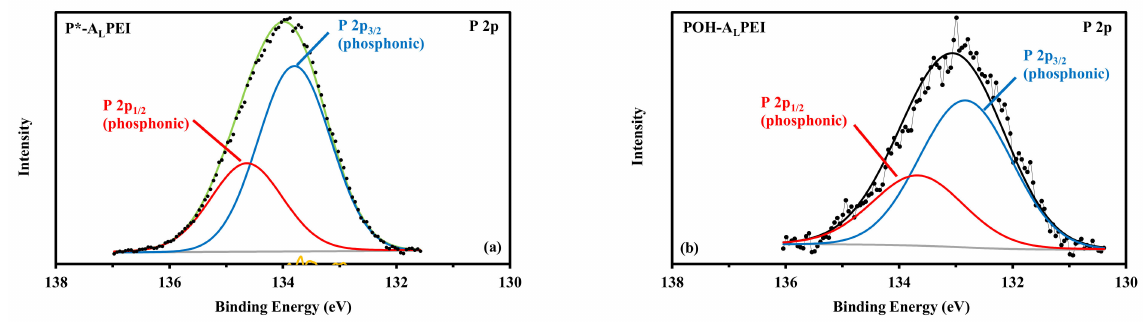
Figure 7. HRES XPS P 2 p core level spectra for P*-A L PEI ( a ) and POH-A L PEI ( b ).